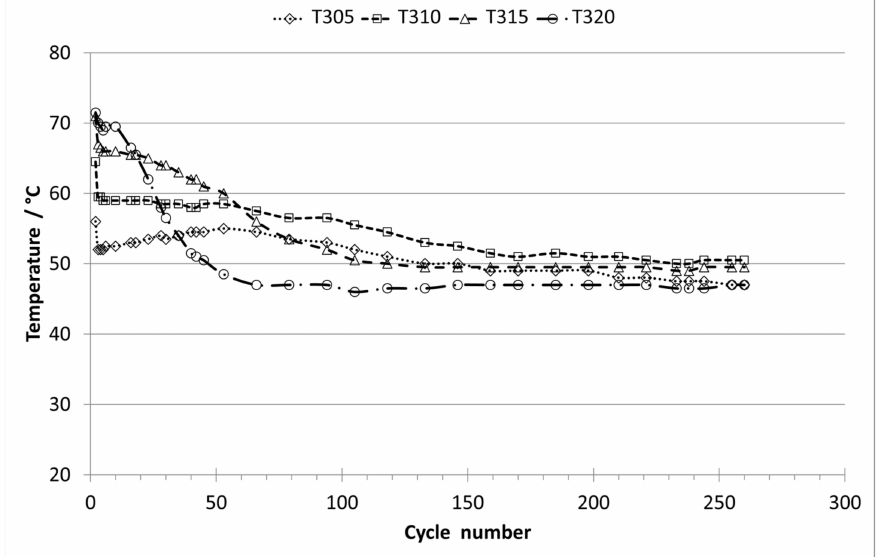
Figure 10. Dependence of the temperature behavior on the cycle number for E10/humid N 2